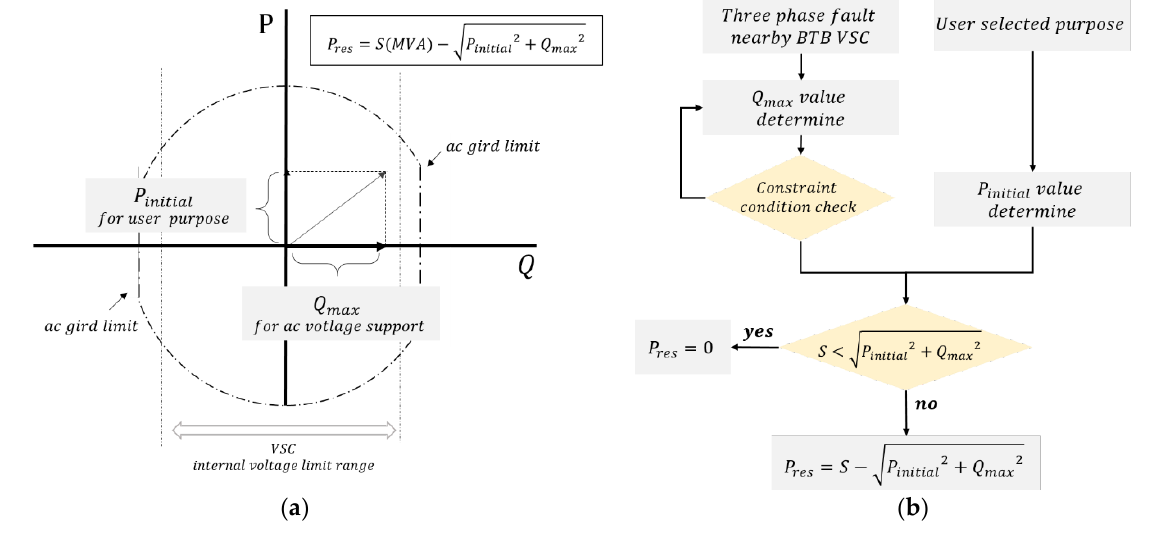
Figure 4. ( a ) Capability curve of BTB VSC and ( b ) determination process of 𝑃 𝑟𝑒𝑠 value.